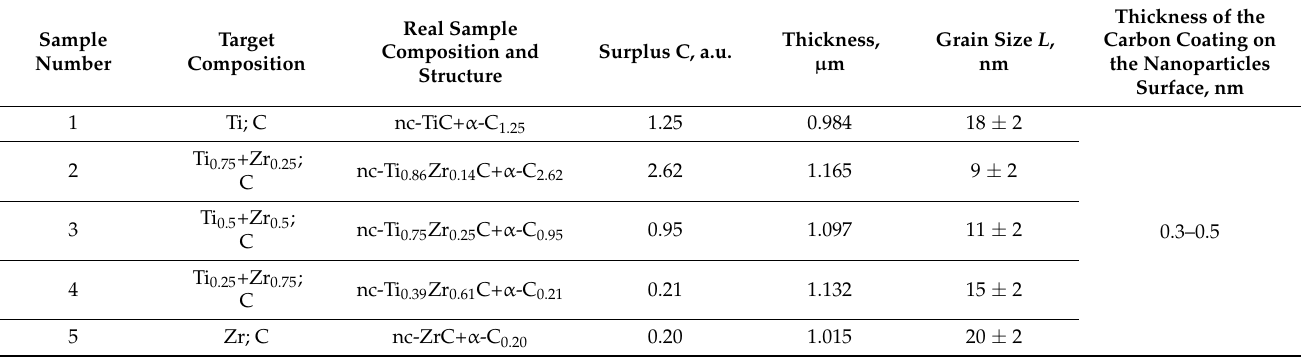
Table 1. Sub-structural parameters of nc-Ti x Zr 1 − x C+ α -C coatings, based on data from